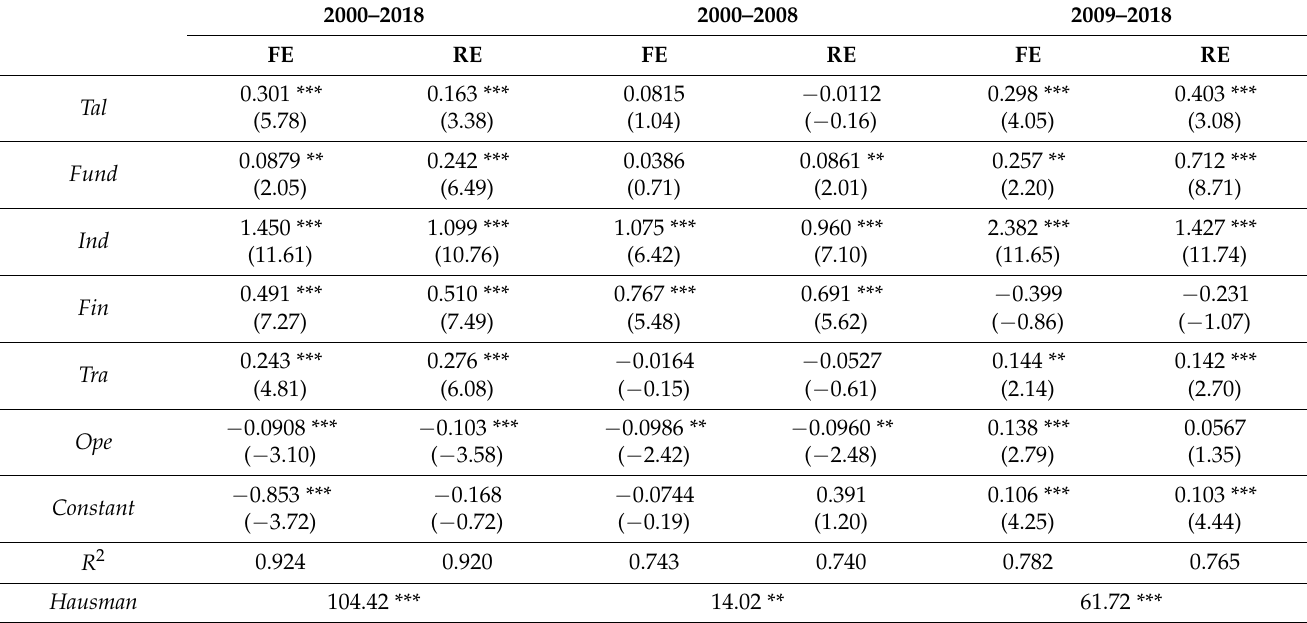
Table 1. Regression results for driving factors for innovation development in the